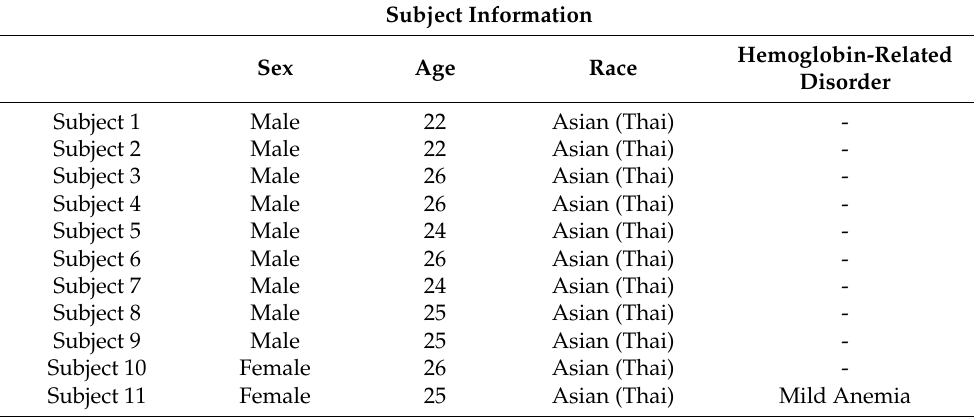
Table 10. Subject